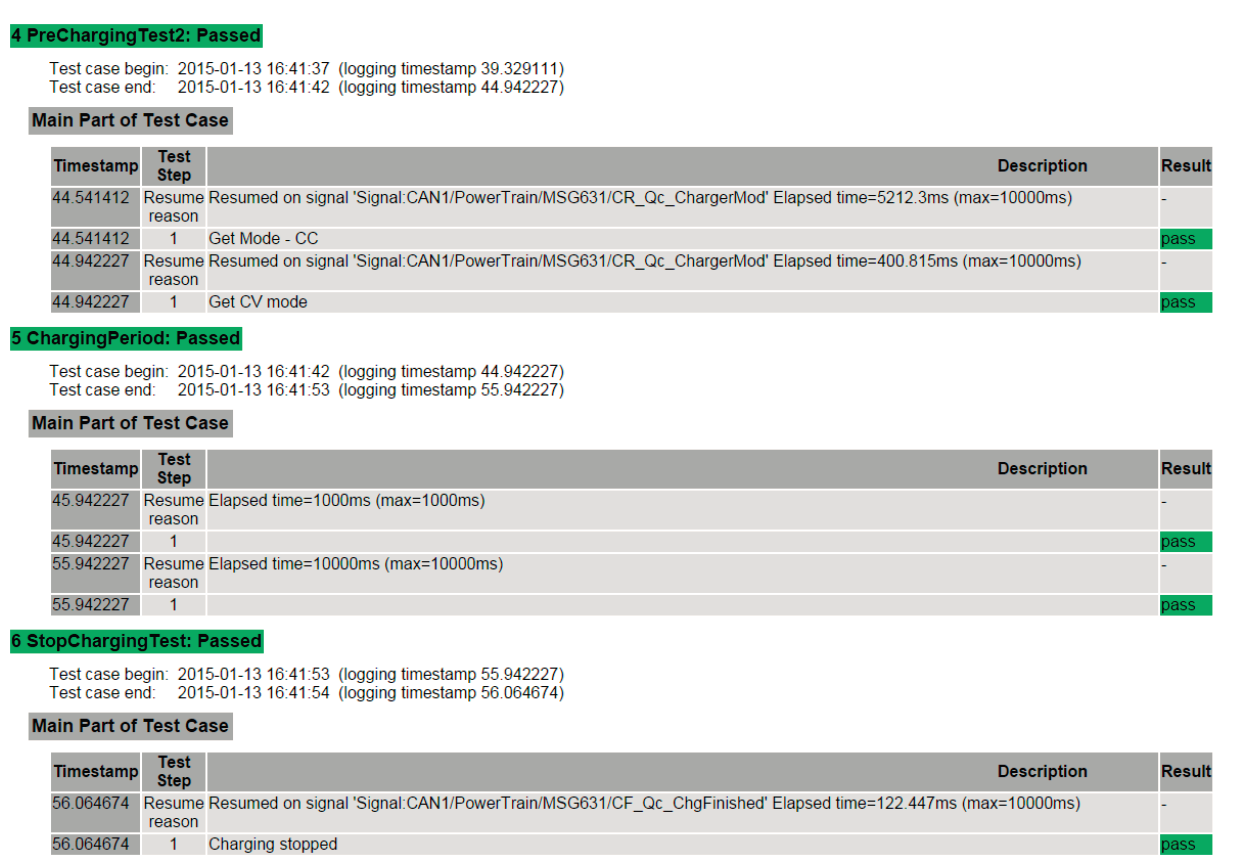
Figure 8. Part of the final report after successfully testing the normal charging